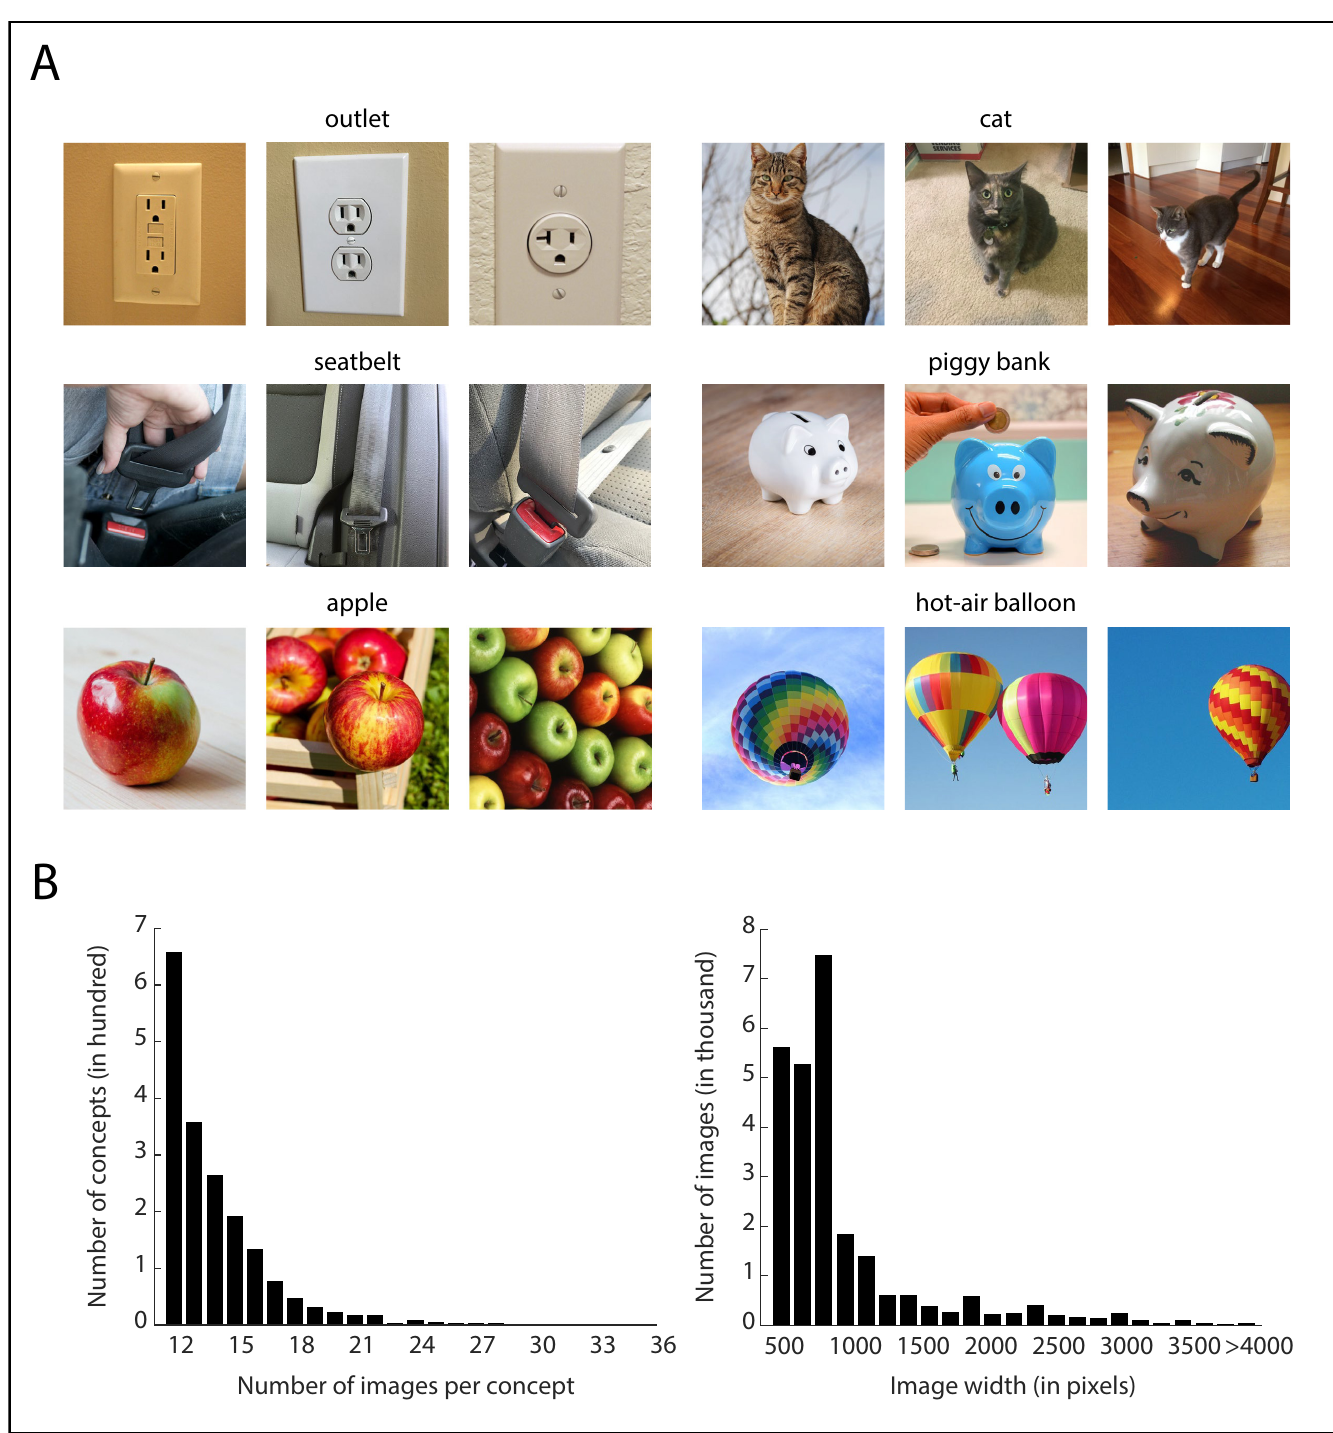
Fig 3. Examples and statistics of images in THINGS database. (A) Example images in THINGS database for different object concepts. Some of the original images were replaced due to the journal’s copyright policy. The original figure can be found at https://www.biorxiv.org/content/10.1101/545954v2. (B) Histograms illustrating the number of images per concept (ranging from 12 to 35) and the image dimensions (peaking at 800